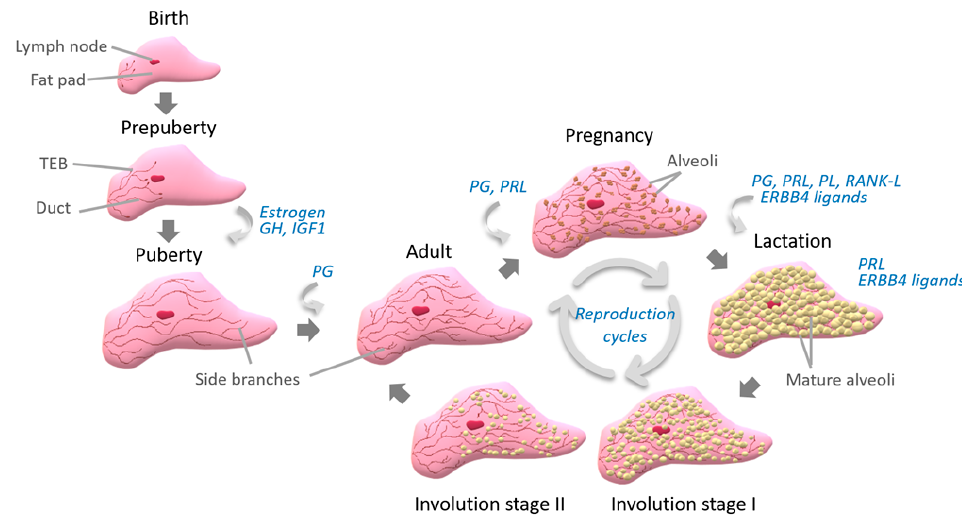
Figure 1. Principal stages of the mammary gland development throughout the lifetime. Major hormones that control development are outlined in italics and blue. TEB: terminal end bud. GH: growth hormone. IGF1: insulin-like growth factor-1. PG: Progesterone. PRL: Prolactin. PL: Placental lactogen. ERBB4: Erb-B2 Receptor Tyrosine Kinase 4. RANK-L: receptor activator of nuclear factor kappa-B ligand.